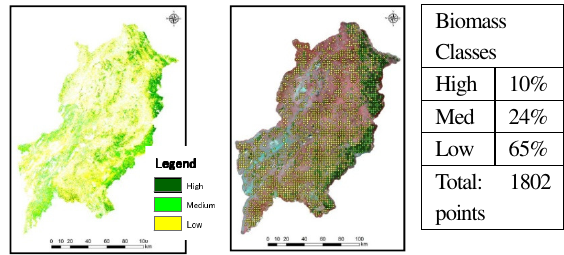
Figure 2. Biomass classing results (2007, LPB province)